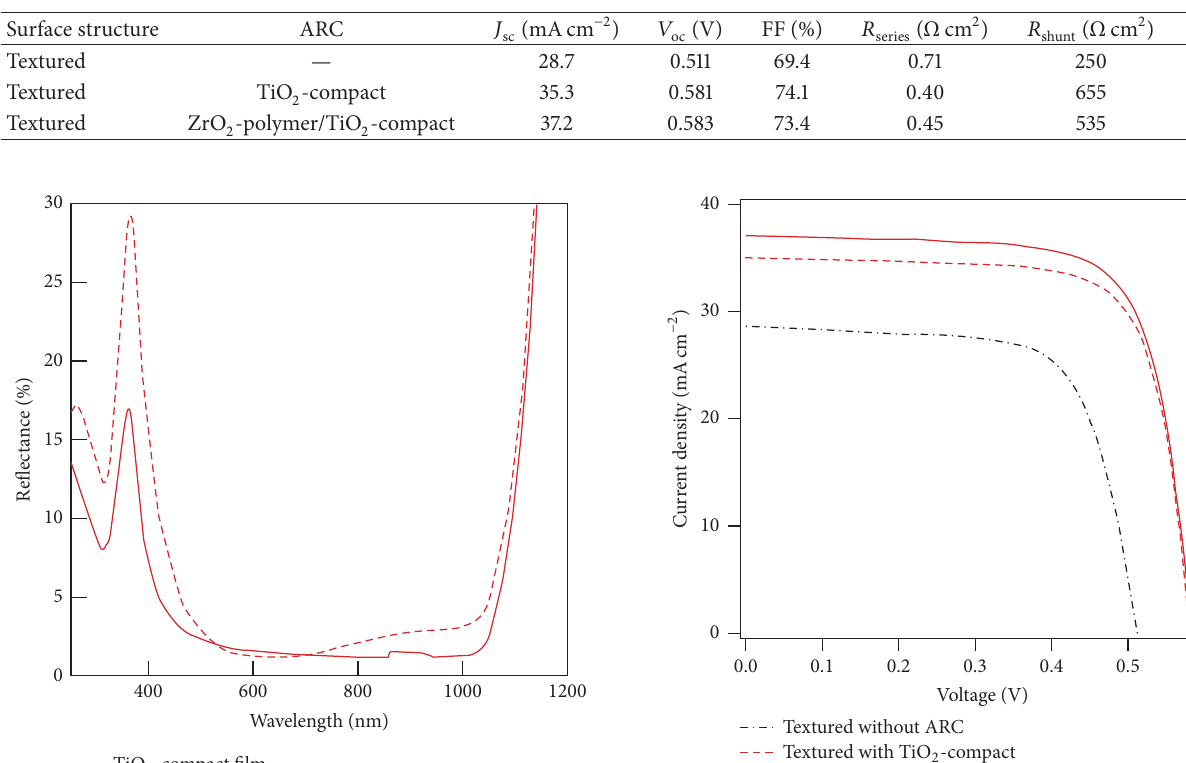
Table 2: Photovoltaic characteristics of fabricated crystalline silicon solar cells with various surface structures with/without antireflection coating on textured surface.